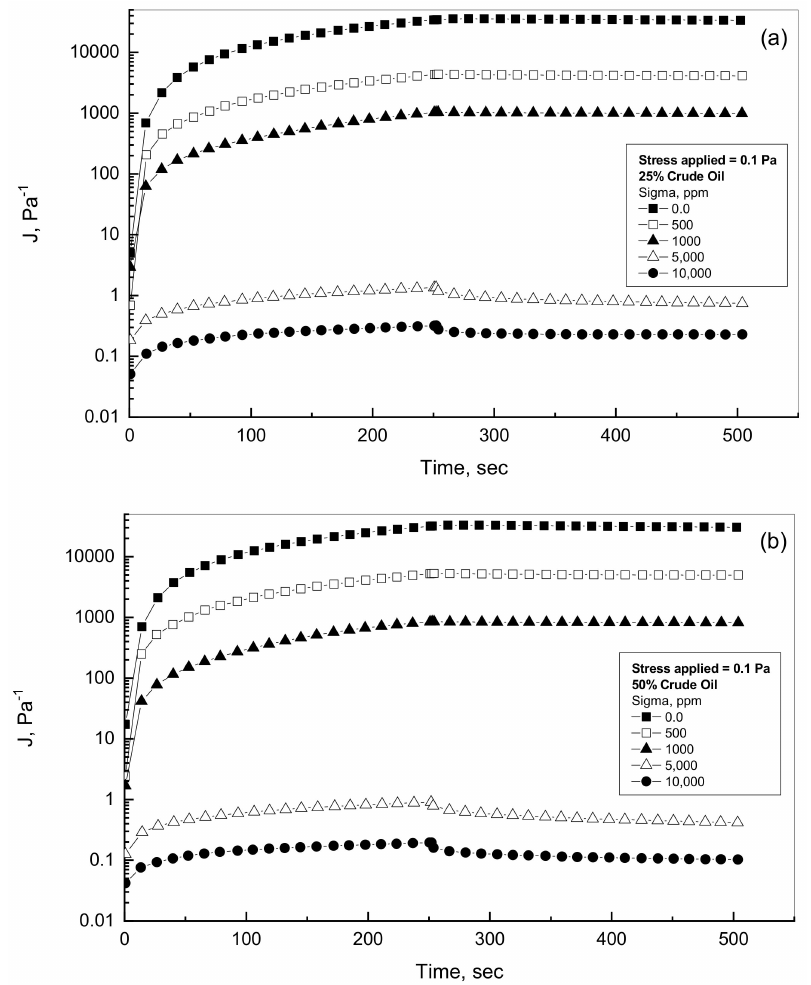
Figure 4. Creep-recovery behavior for 25% and 50% crude oil-Sigma emulsions. ( a ) 25% oil-Sigma emulsions; ( b ) 50% oil-Sigma emulsions.